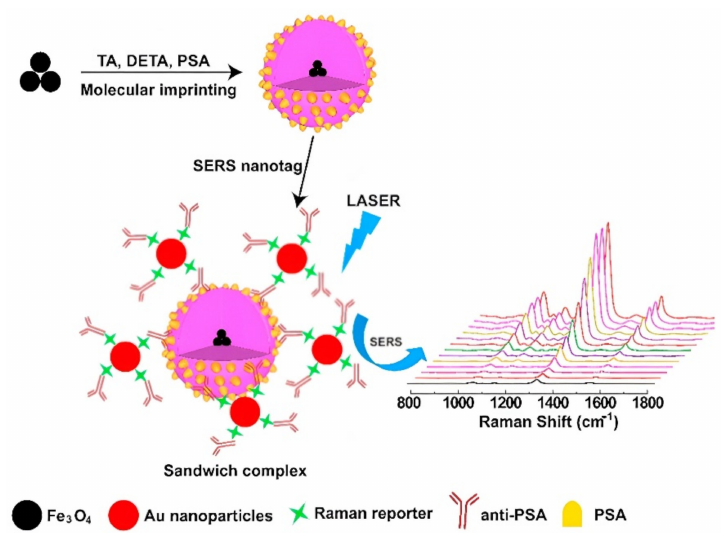
Figure 4. The schematic of plasmonic biosensor for prostate-specific antigen by combining magnetic molecularly imprinted polymer and surface-enhanced Raman spectroscopy. Reprinted from [72] with permission of Elsevier provided by Copyright Clearance